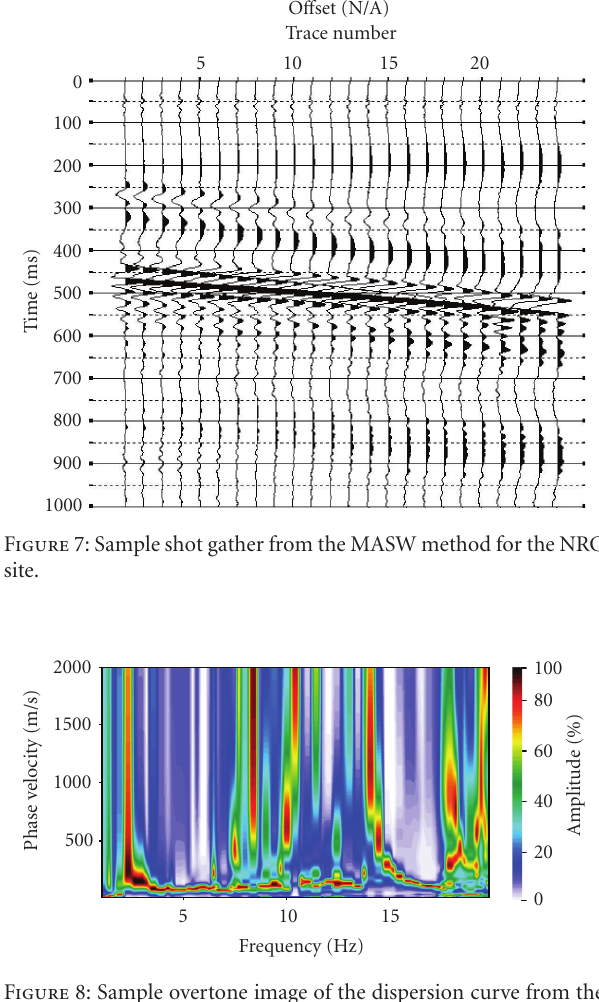
Figure 8: Sample overtone image of the dispersion curve from the combined MASW method for the NRC site located in the southern part of the city of Ottawa.